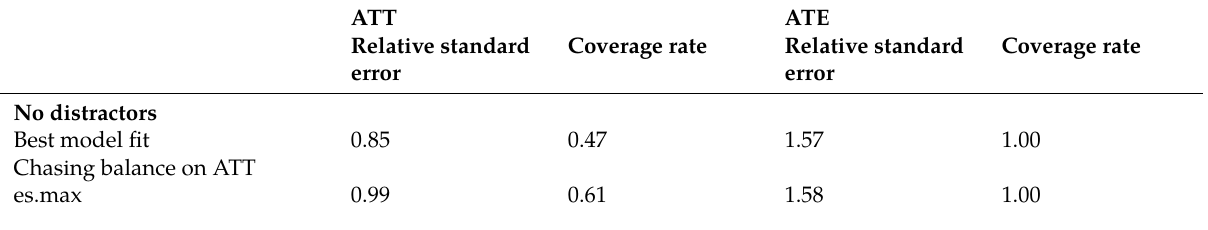
Table 9: Relative standard errors and coverage rates for all stopping rules and methods considered for the PA example. ATT